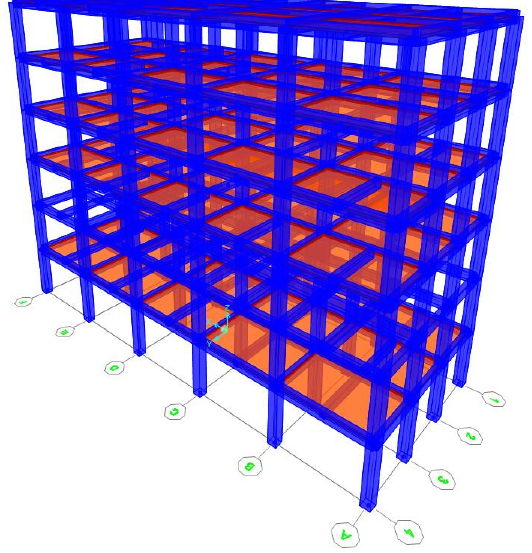
Figure 11. Schematic diagram of the three-dimensional structure model.